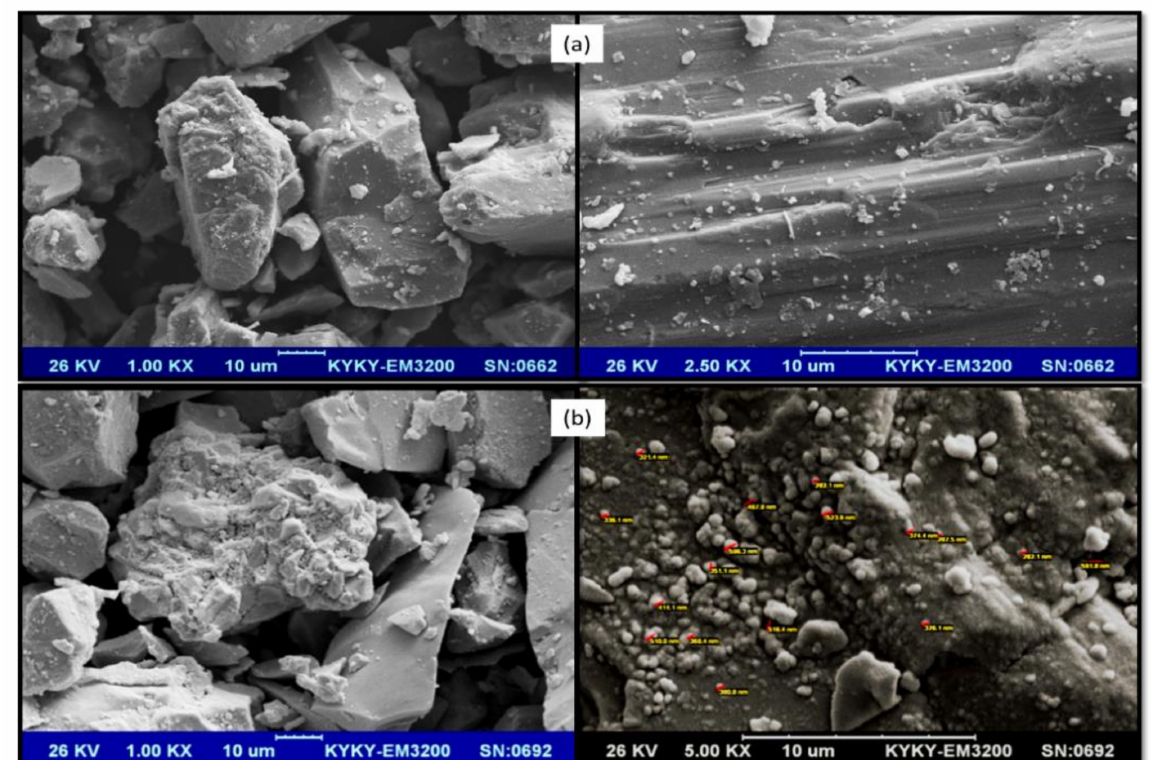
Figure 6. SEM images of: ( a ) NP, and ( b ) 6-recycled NP.